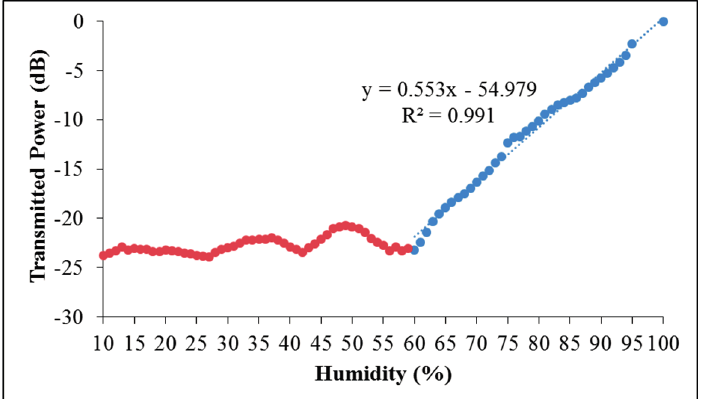
Figure 4. Linear response to humidity in the range of 60% RH to 100%